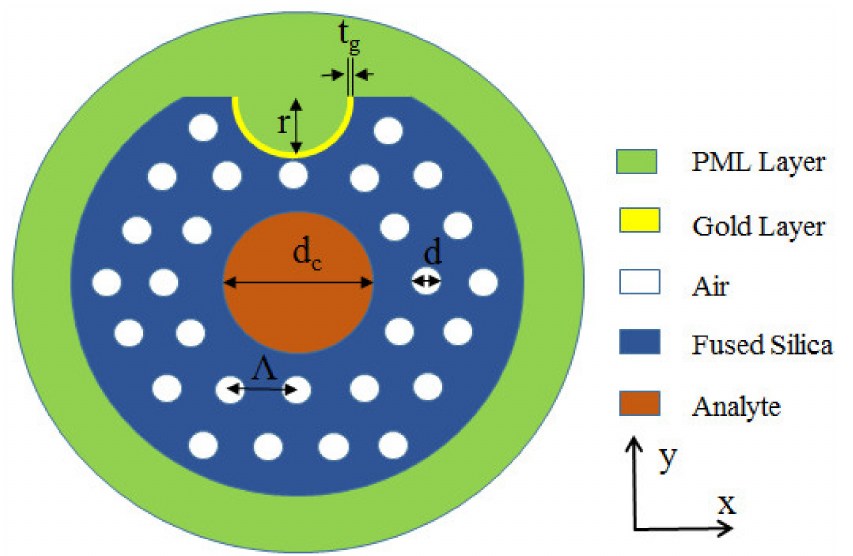
Figure 1. Geometry with labeled pore diameter (d), analyte-core diameter (d c ), pore spacing ( Λ ), Au layer thickness (t g ) and micro-channel radius